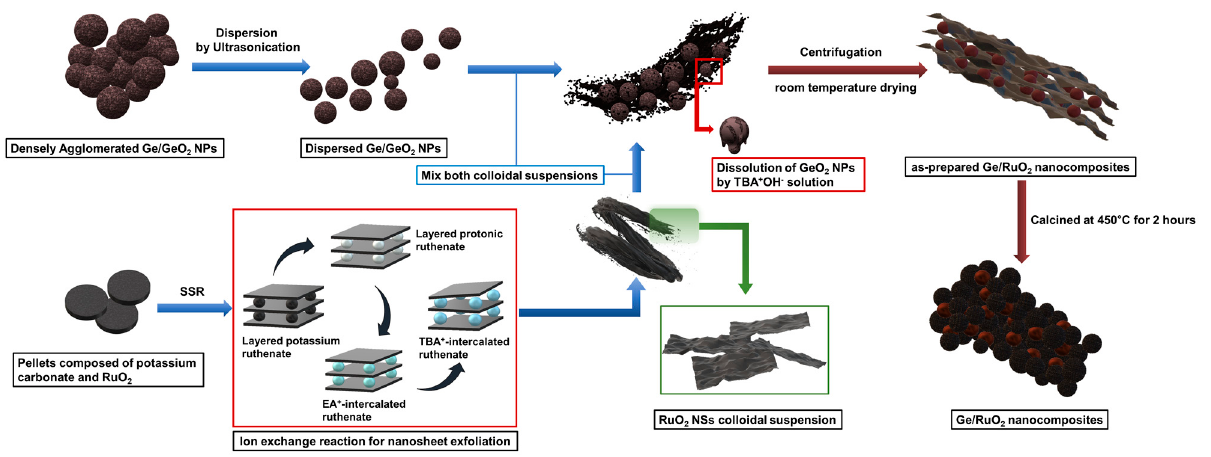
Figure 1. Schematic of synthesis of Ge/RuO 2 nanocomposites.